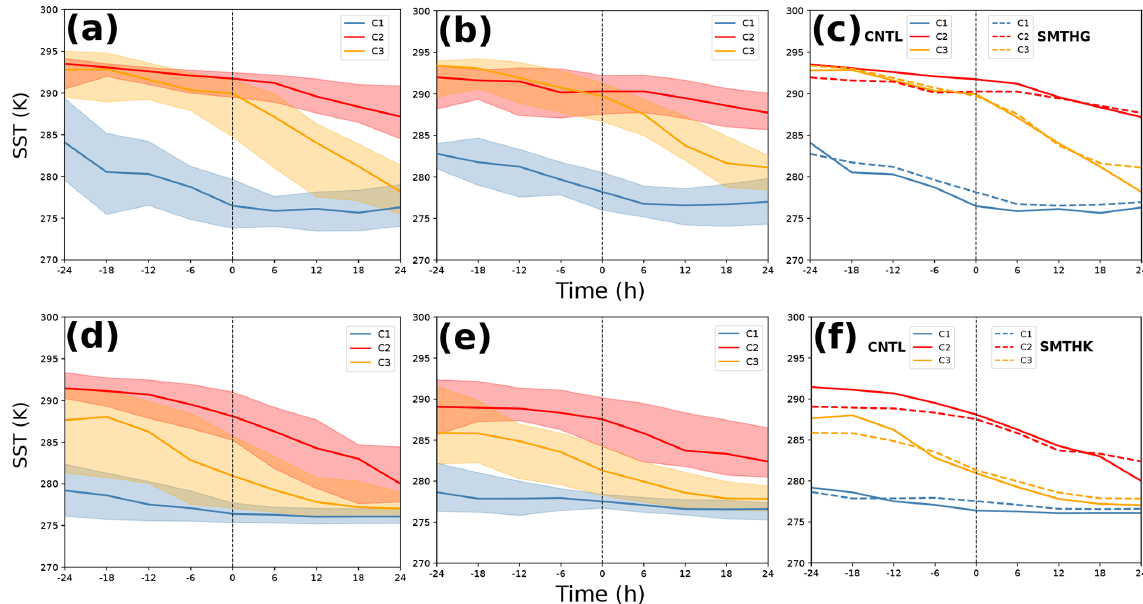
Figure 6. SSTs (K) for the three categories relative to the time of maximum intensification for (a) CNTL and (b) SMTHG. Lines indicate the median and the shading the interquartile range. (c) Medians of the SST [K] underneath the cyclone for the three categories relative to the time of maximum intensification for CNTL (solid lines) and SMTHG (dashed lines). (d–f) As panels (a) – (c) but for the North